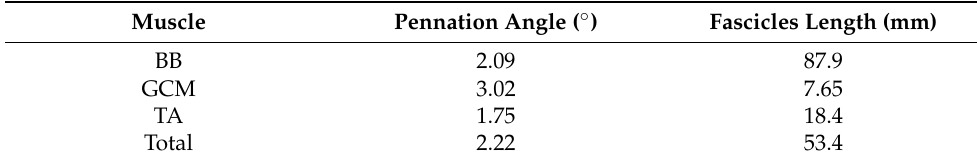
Table 3. Comparative RMSE results of the pennation angle and fascicle length measurements. The fascicle length is measured in mm and the pennation angle in degrees.